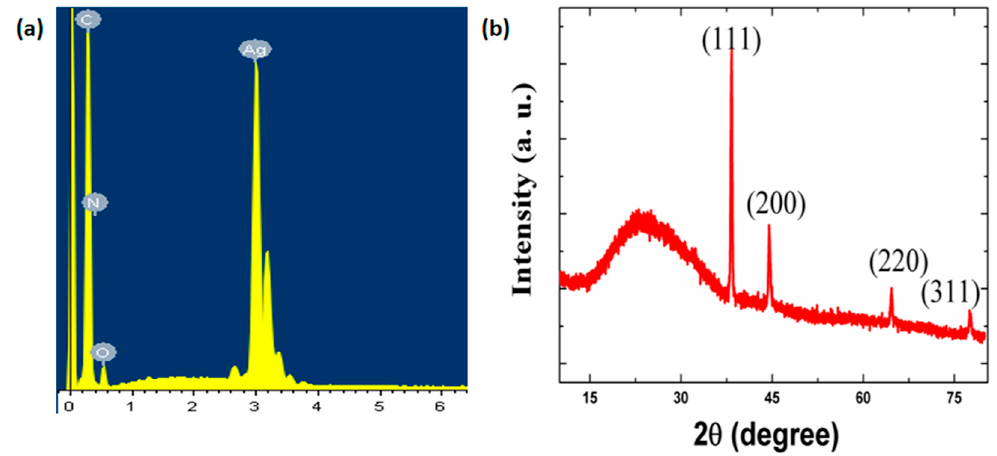
Figure 2. ( a ) The EDS spectrum of the strain sensor. ( b ) The XRD map of the strain sensor.